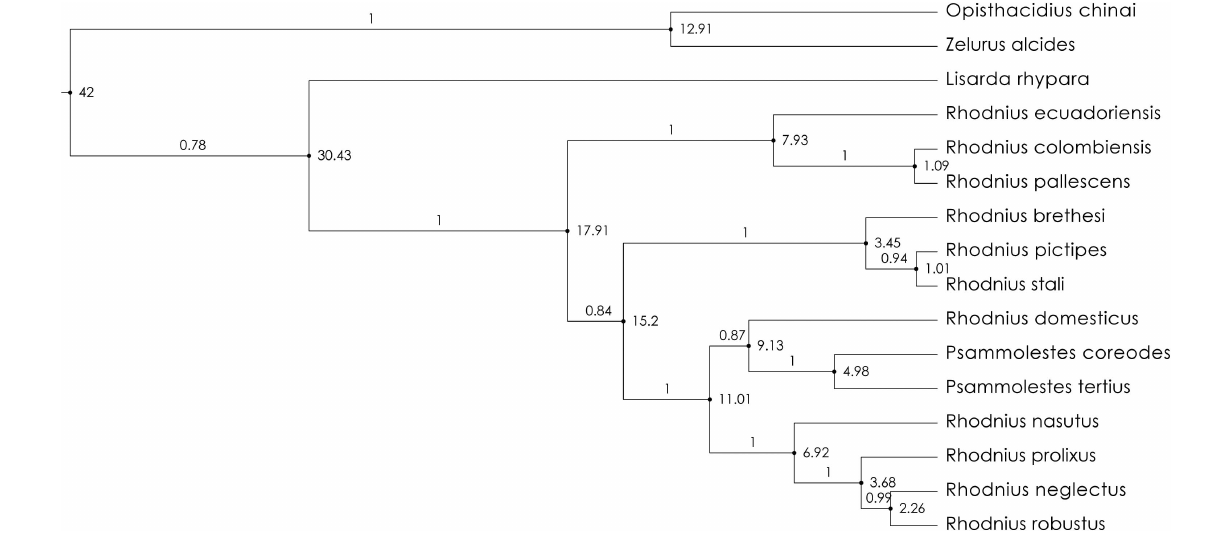
(Kappa = 0.218) to the north of its distributional area.